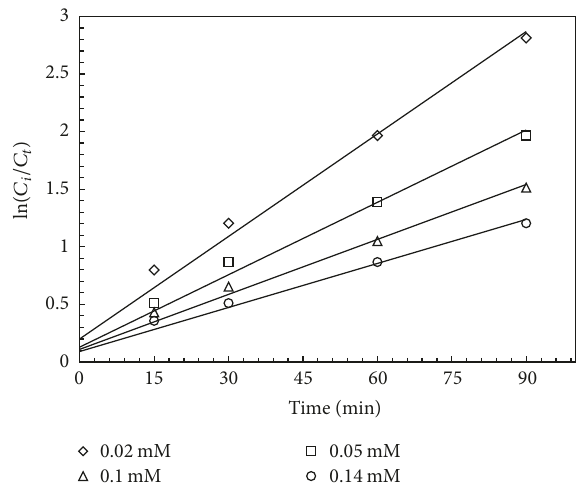
Figure 6: ln (𝐶 𝑖 /𝐶 𝑡 ) versus reaction time.